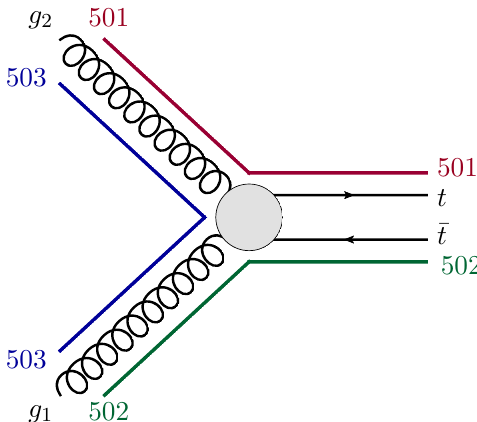
Figure 10 . Color dipoles in the sample top-pair production event discussed in